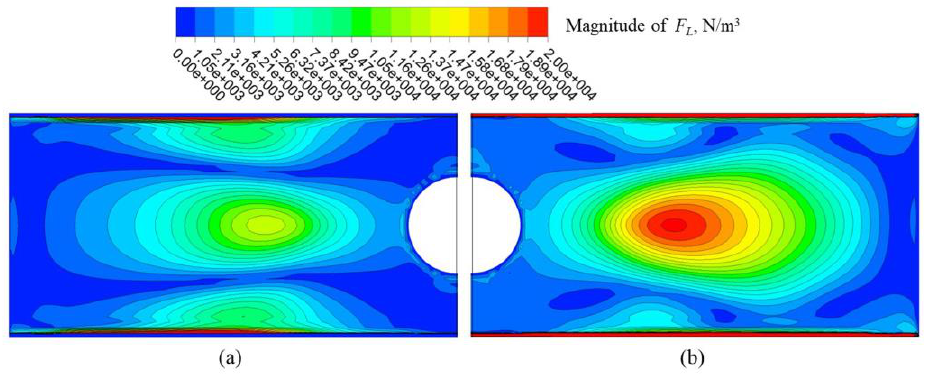
Figure 13. Contours of time-averaged electromagnetic force on plane 1 ( a ) EMBr with electrically-insulated walls; ( b ) EMBr with electrically-conducting walls.